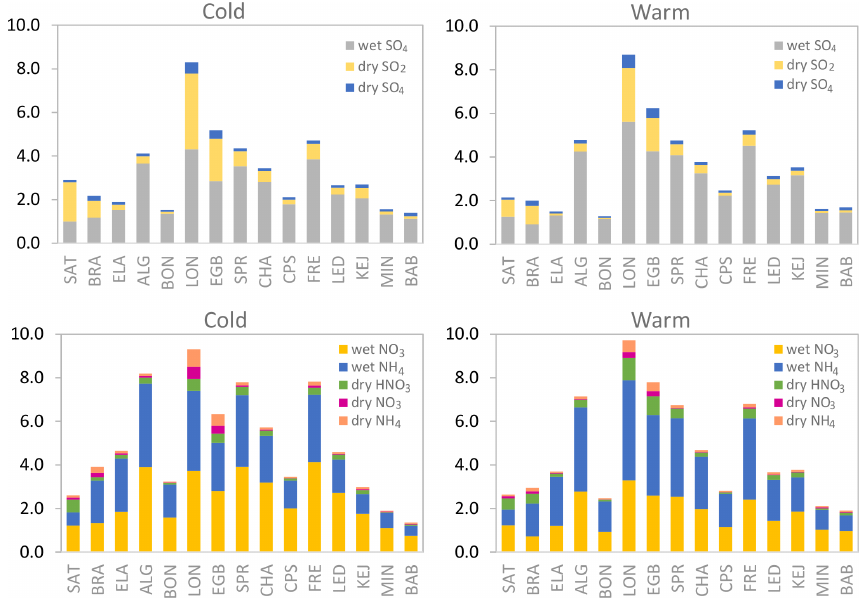
Figure 8. Mean total (dry + wet) deposition fluxes of N and S species in kgN or Sha − 1 yr − 1 during the cold (November–April) and warm (May–October) seasons at CAPMoN sites during 2000–2018. Sites are listed in order longitudinally from west (left) to east